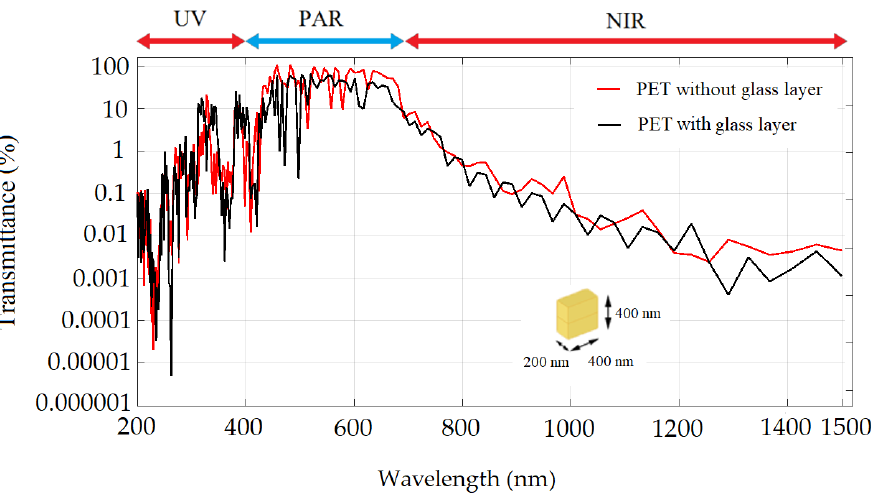
Figure 8. The transmittance of a film (with and without a glass layer).